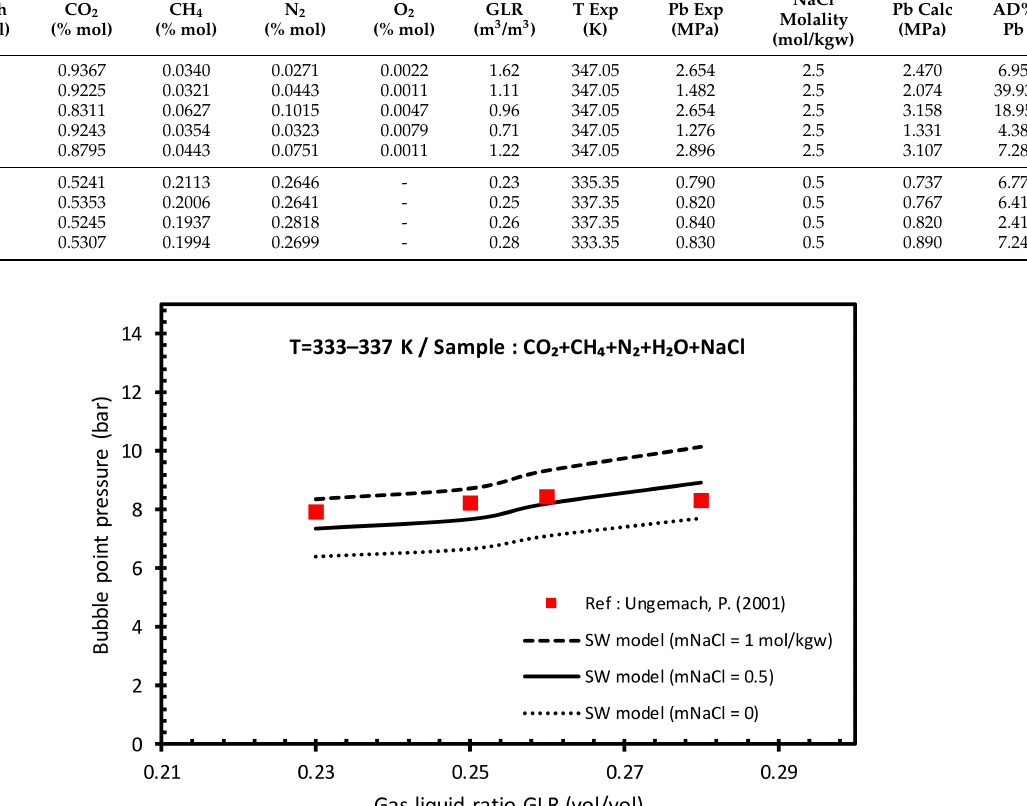
Table 4. Comparison of predicted bubble pressures (Pb) with those obtained from PVT data of downhole samples [31,85]. Data Source